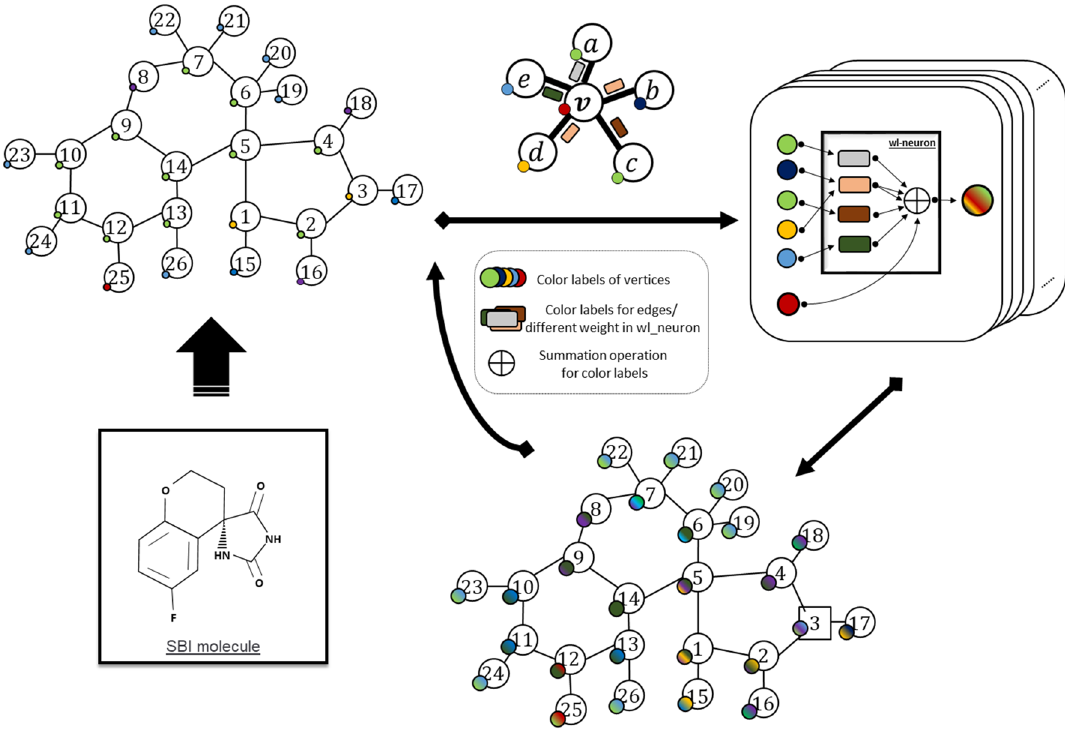
Figure 5. Weisfeiler–Lehman